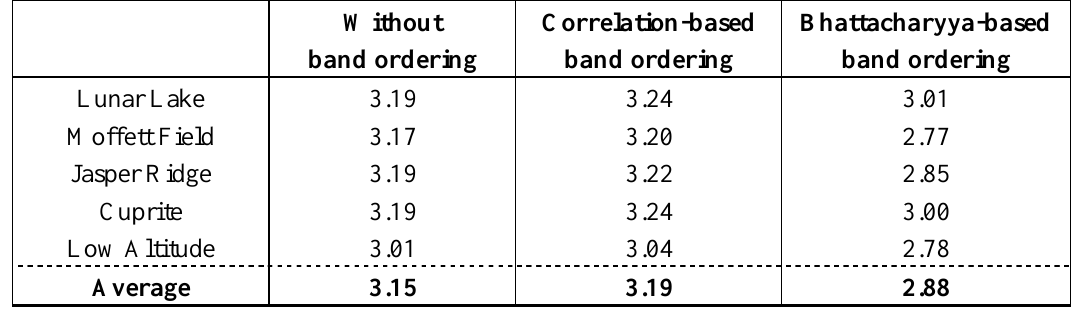
Table 7. Average results in terms of C.R. for each hyperspectral image without ordering, with Pearson’s correlation-based band ordering and Bhattacharyya distance-based band ordering.